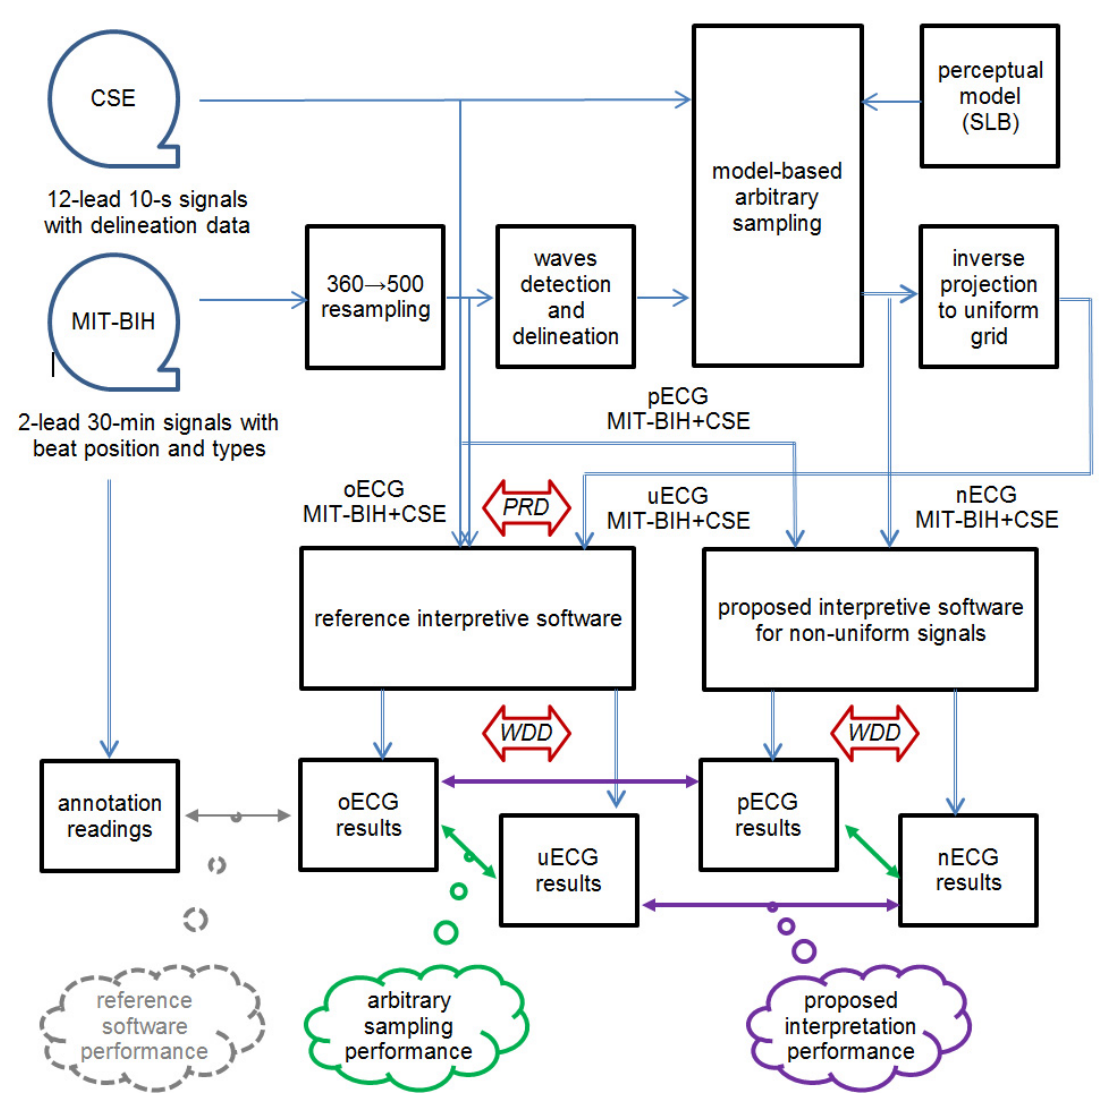
Figure 7. The experiment flow diagram; oECG stands for original records (from both databases), pECG stands for pseudo-non-uniform records (i.e., uniform records in non-uniform data format), nECG stands for non-uniform records (according to arbitrary sampling model) and uECG stands for uniform records produced by projections of nECG to uniform sampling grid.